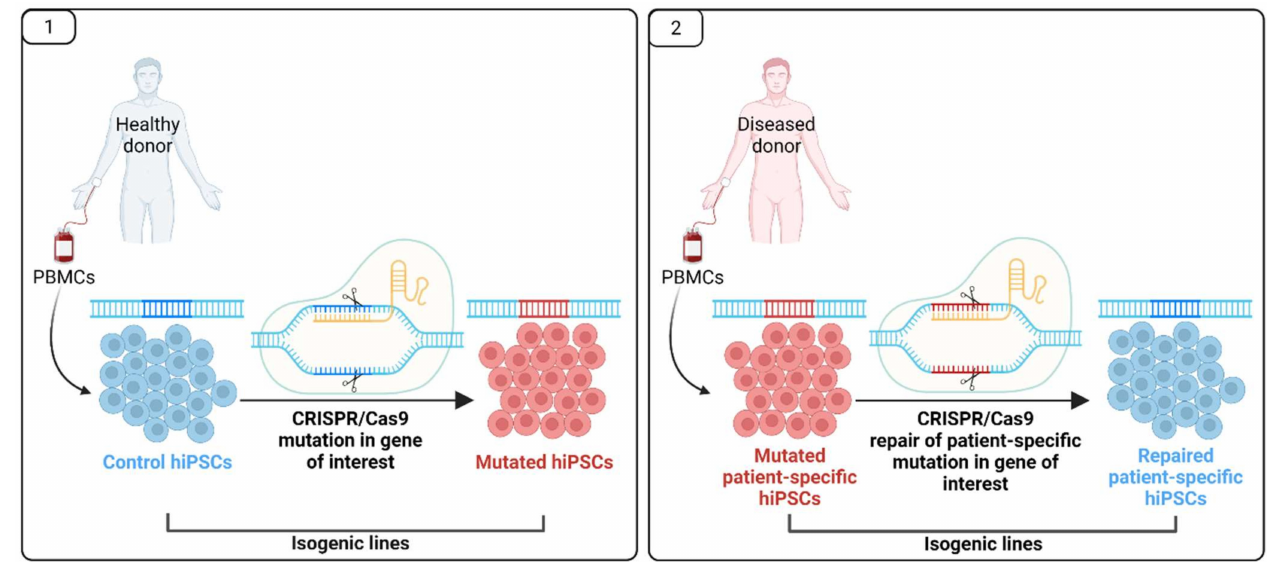
Figure 5. Approaches for generation of human disease-relevant isogenic lines: ( 1 ) starting from healthy or ( 2 ) diseased individual. Figure created with